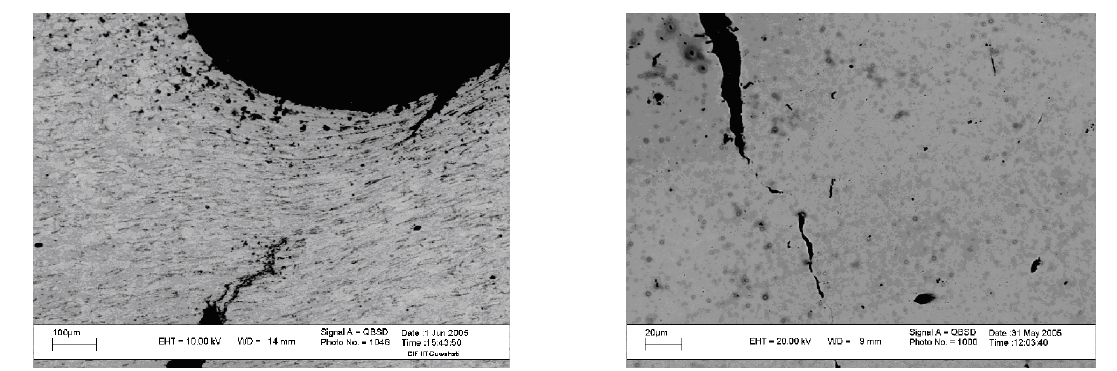
Figure 16: Void coalescence in front of crack. Figure 17: Multi-crack formation.